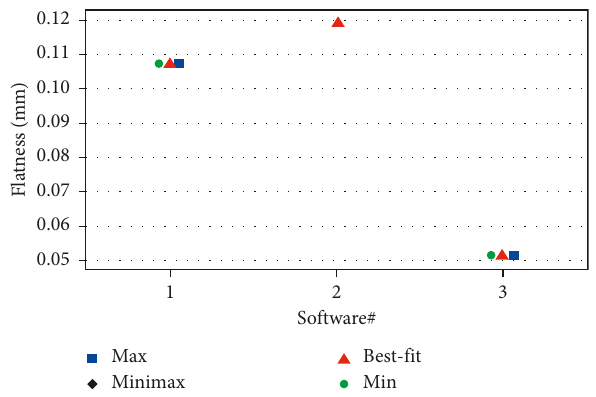
Figure 7: Results of flatness analysis (Plane A). Table 6: Results of inspection of Plane D.